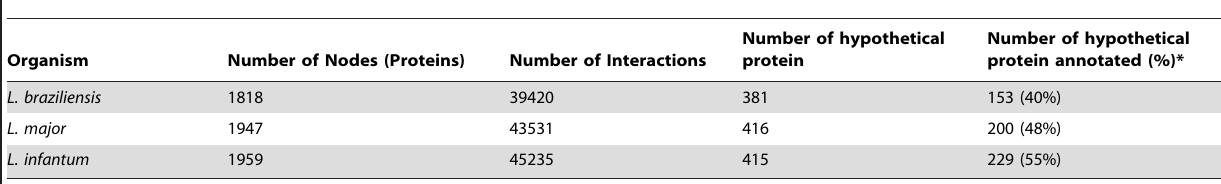
Table 4. General features of the three predicted PPI Networks.